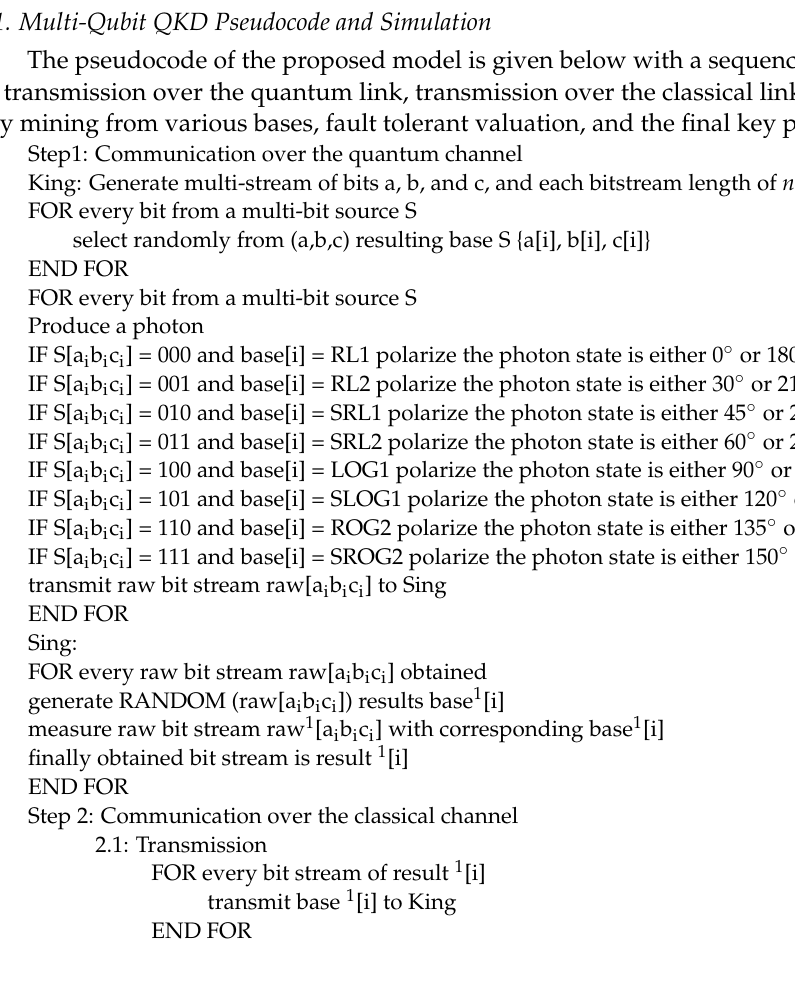
Figure 2. The multi-qubit octal states depiction of the proposed model. public String createRandomBase() { double base_num = qubit.randomGenerator(); if (base_num <0 && base_num <0.25) base = “±”; else if (base_num >0.25 && base_num<0.5))